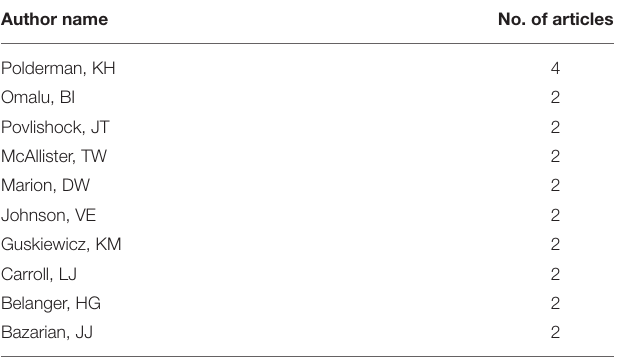
TABLE 4 | Authors with two or more top-cited articles. TABLE 5 | Institutions with more than two top-100 cited